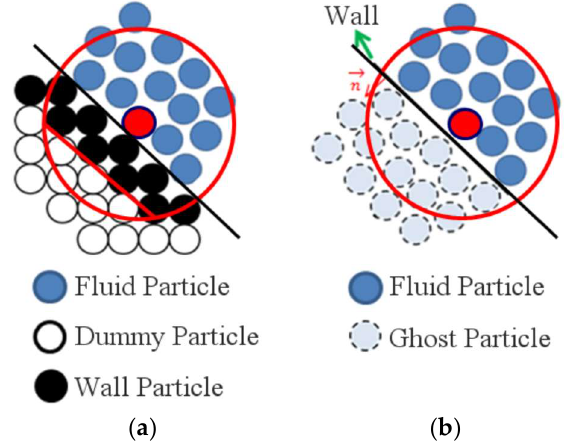
Figure 2. Schematic view of ( a ) fixed- and ( b ) moving-particle wall boundary treatment.